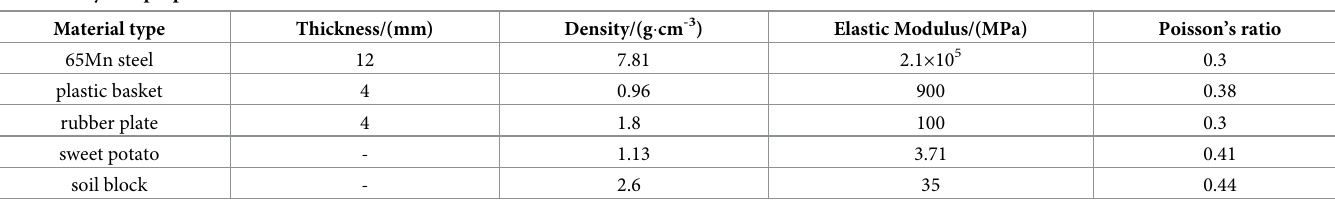
Table 1. Physical properties of collision materials.